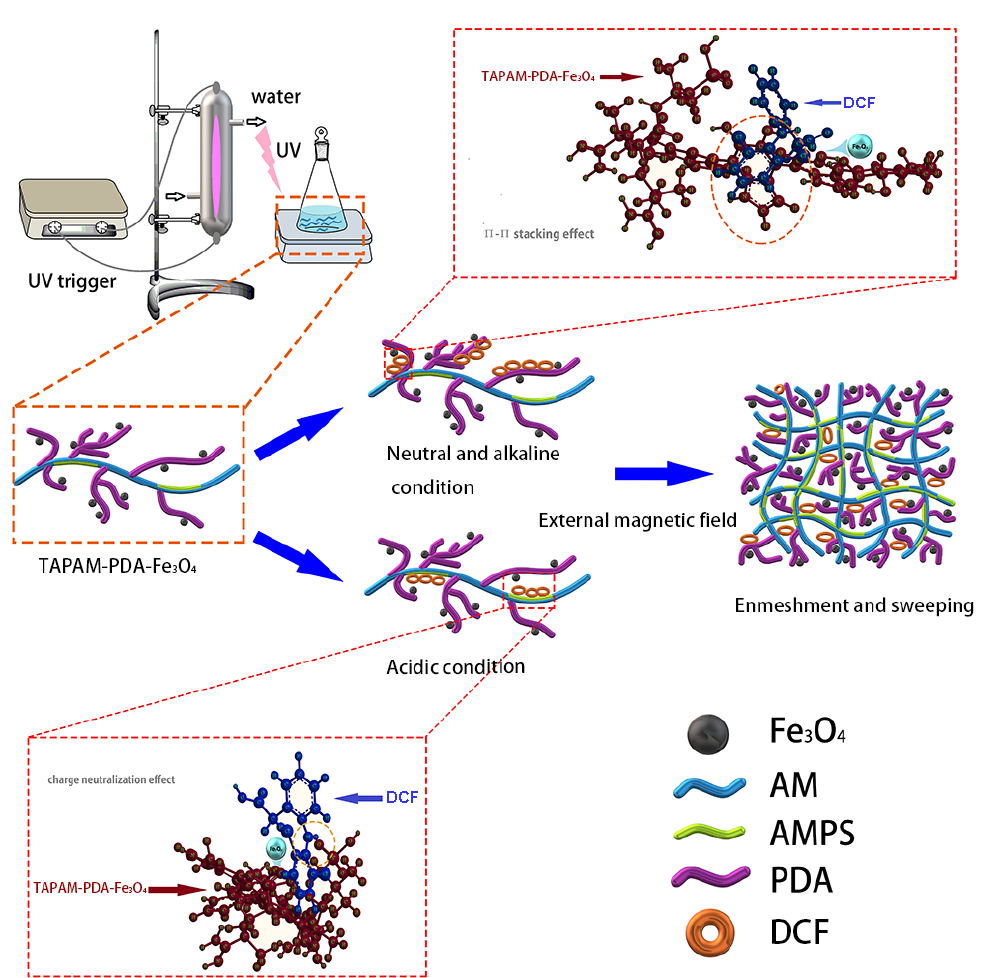
Figure 9. The scheme of DCFS enrichment mechanism by TAPAM-PDA-Fe 3 O 4. (The detail schemes of the TAPAM-PDA-Fe 3 O 4 structure, π–π stacking and charge neutralization effect were depicted in the dotted circles.)